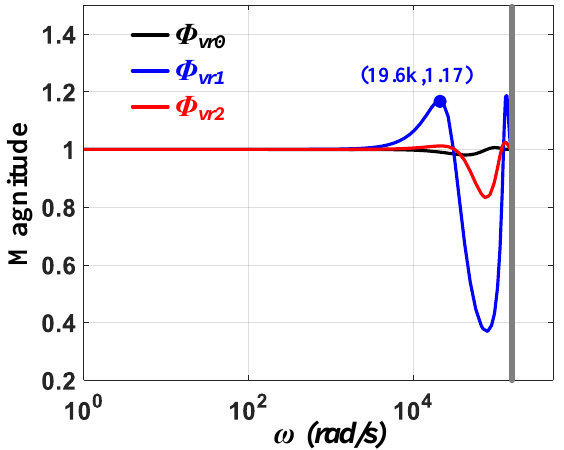
Figure 13. Frequency responses of the closed-loop Figure 4. Frequency responses of the closed-loop systems.